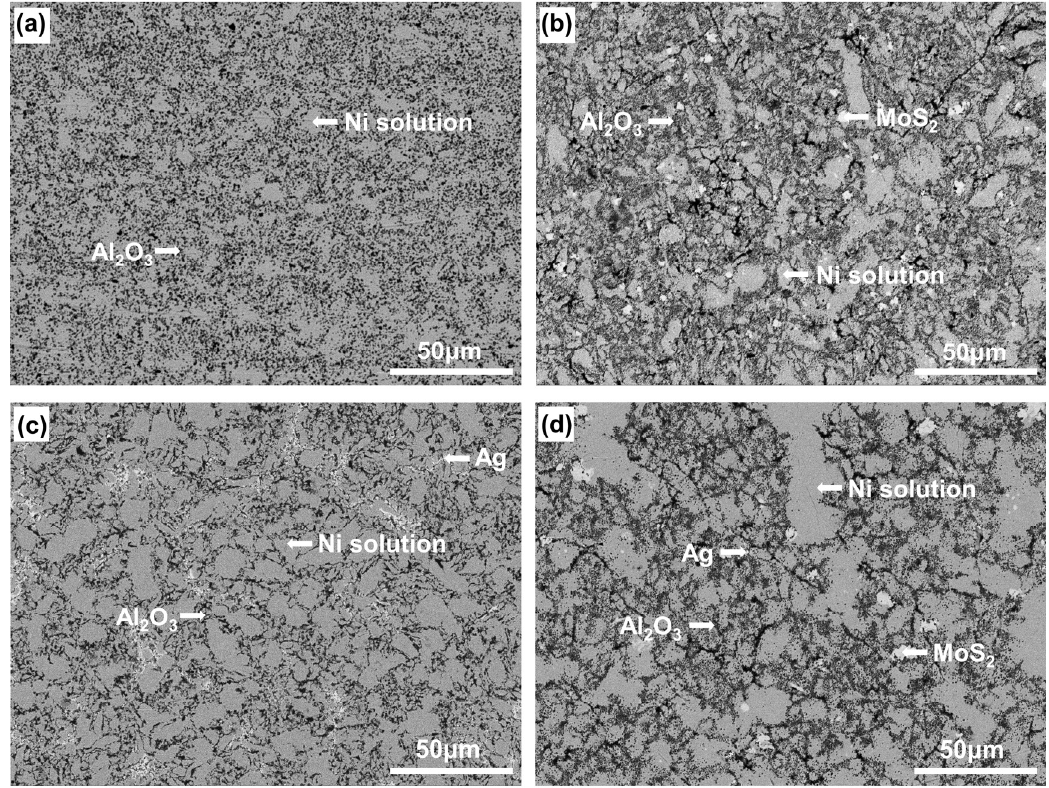
Figure 2. BEI micrographs of composites: ( a ) N, ( b ) NM, ( c ) NA, and ( d ) NMA.